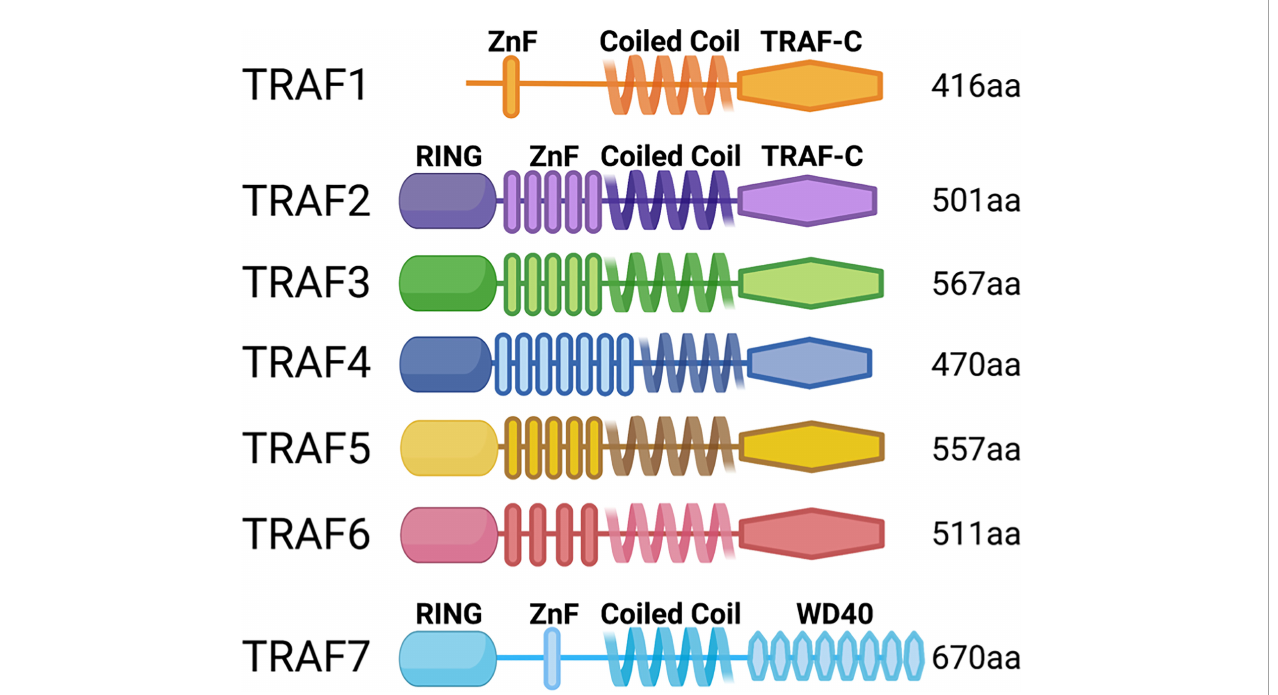
FIGURE 1 TRAF family member domain structures. TRAFs 2-6 are structurally very similar, but TRAFs 1 and 7 are distinct: TRAF1 lacks the RING domain, and TRAF7 lacks the TRAF-C domain and instead has C-terminal WD40